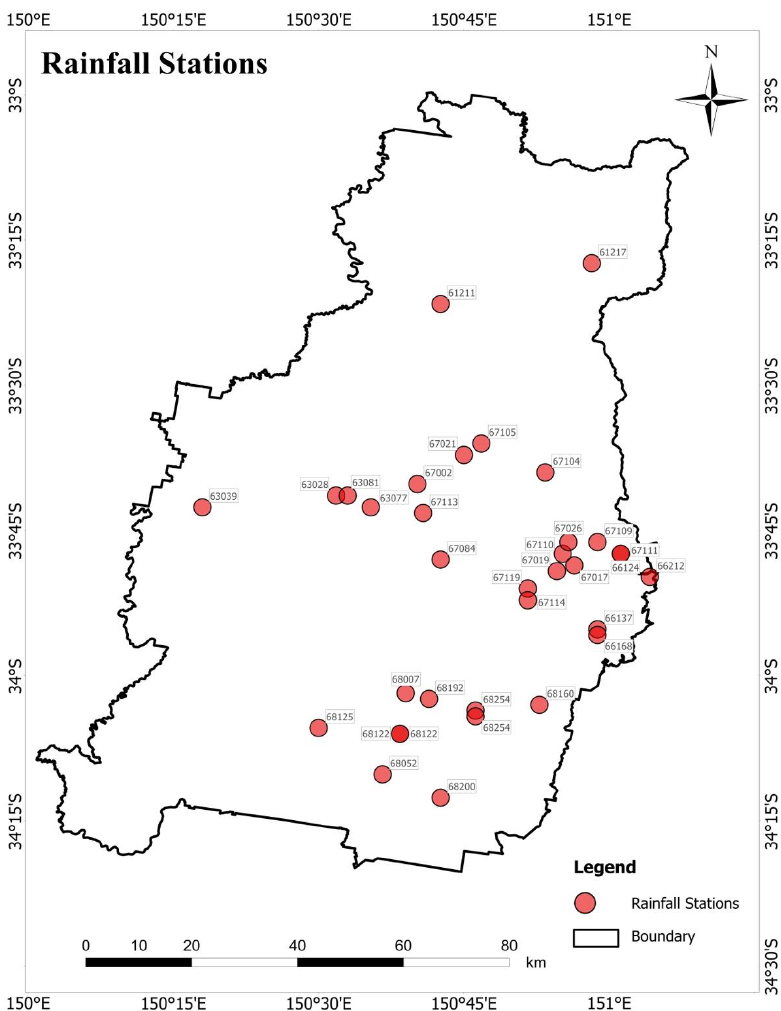
Figure 2. Rainfall stations map of the study area. Table 2. Summary of source of data used in this